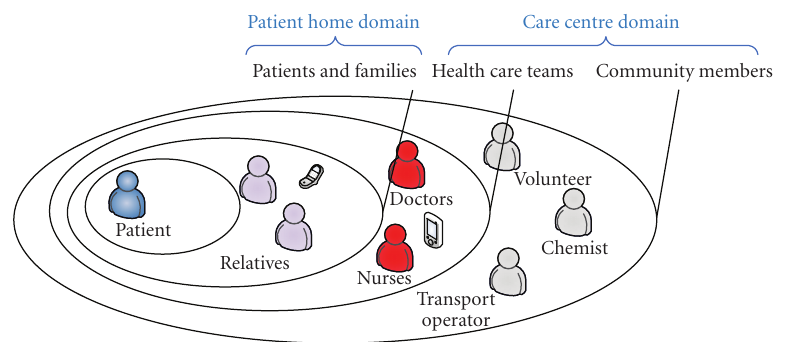
Figure 1: ERMHAN applications